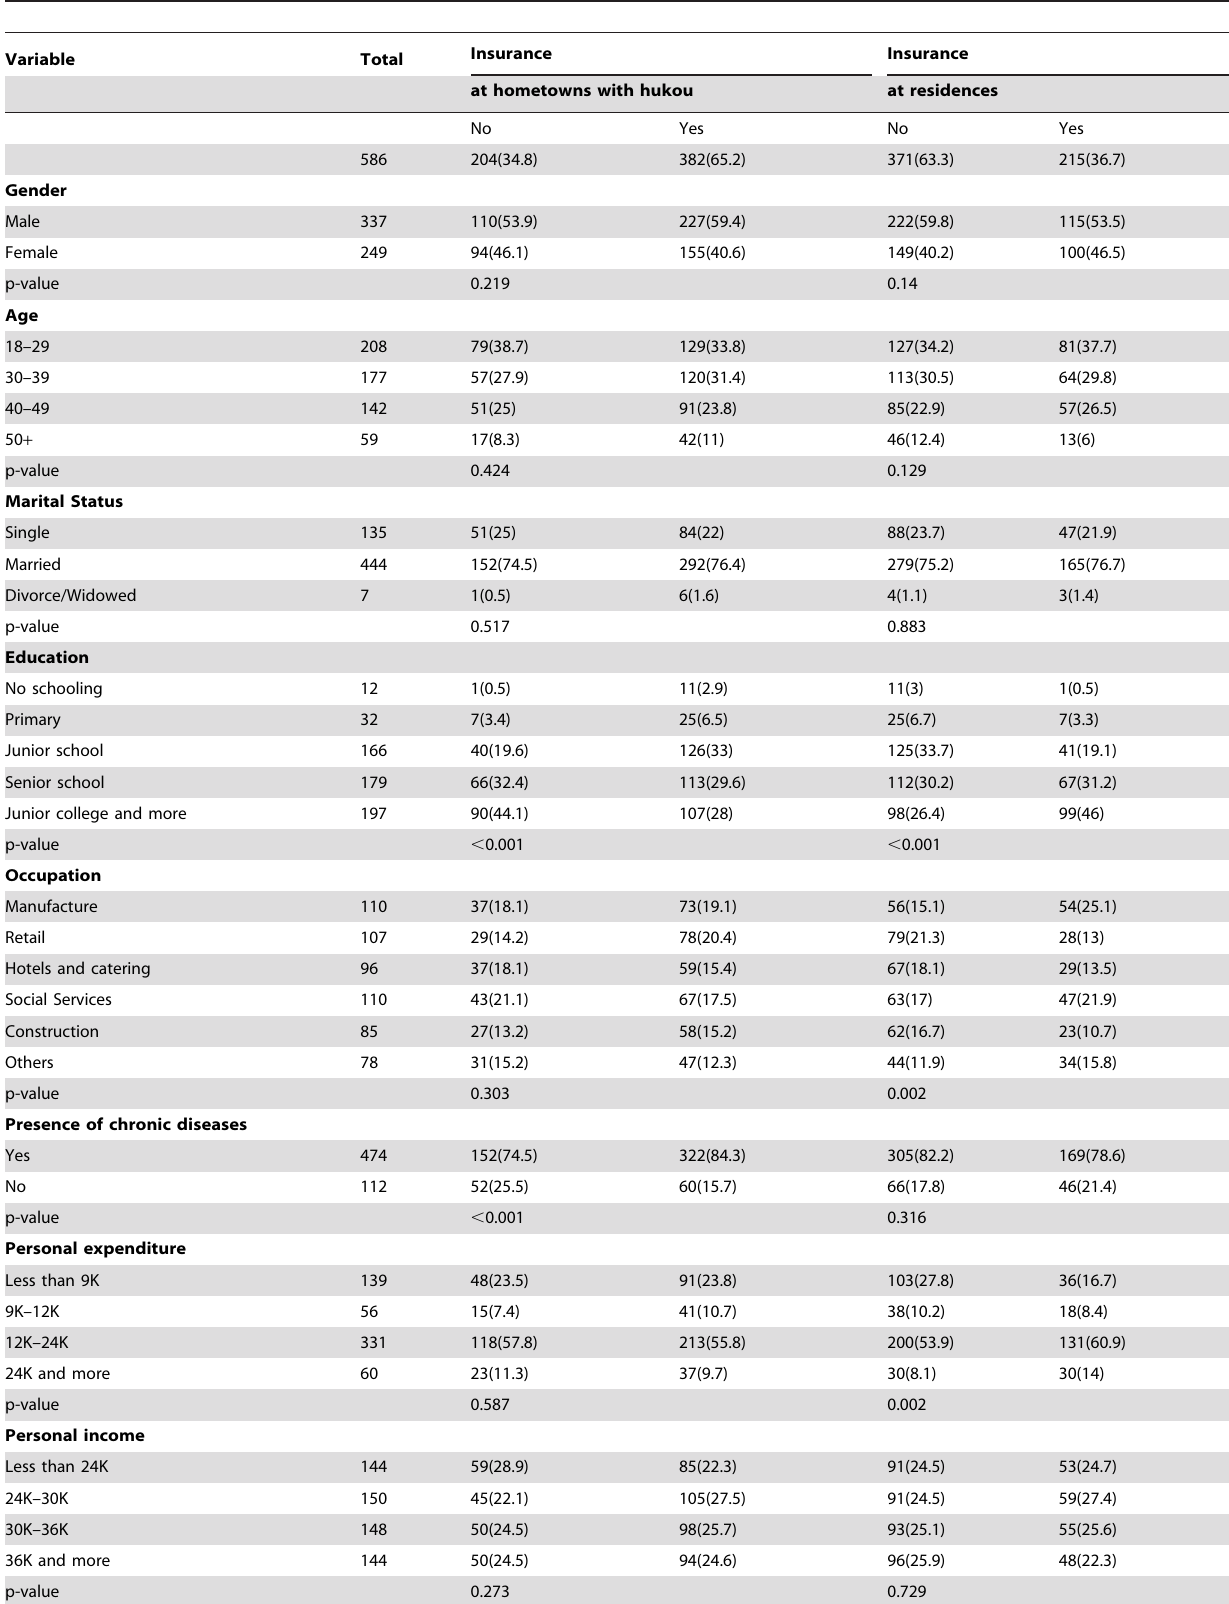
Table 1. Basic characteristics of all subjects and subsets with different insurance coverage status.